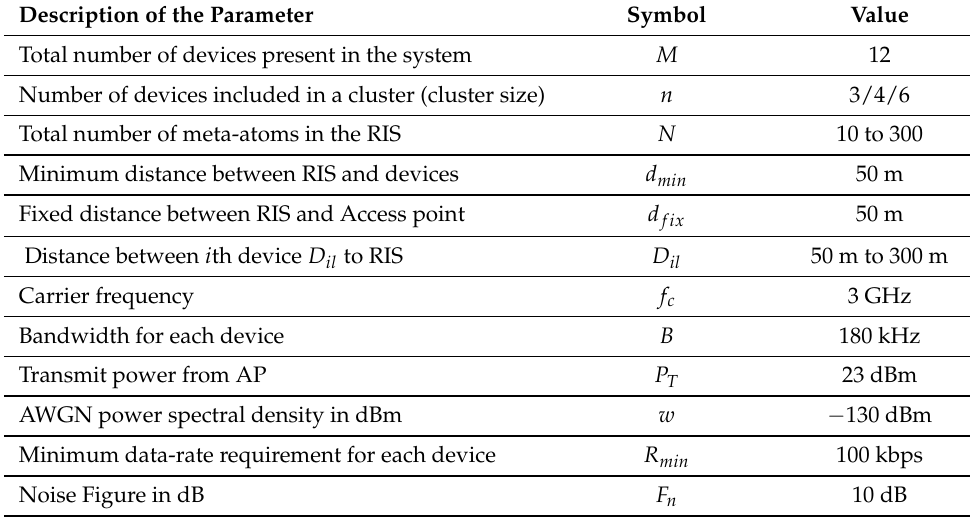
Table 3. Simulation Parameters.